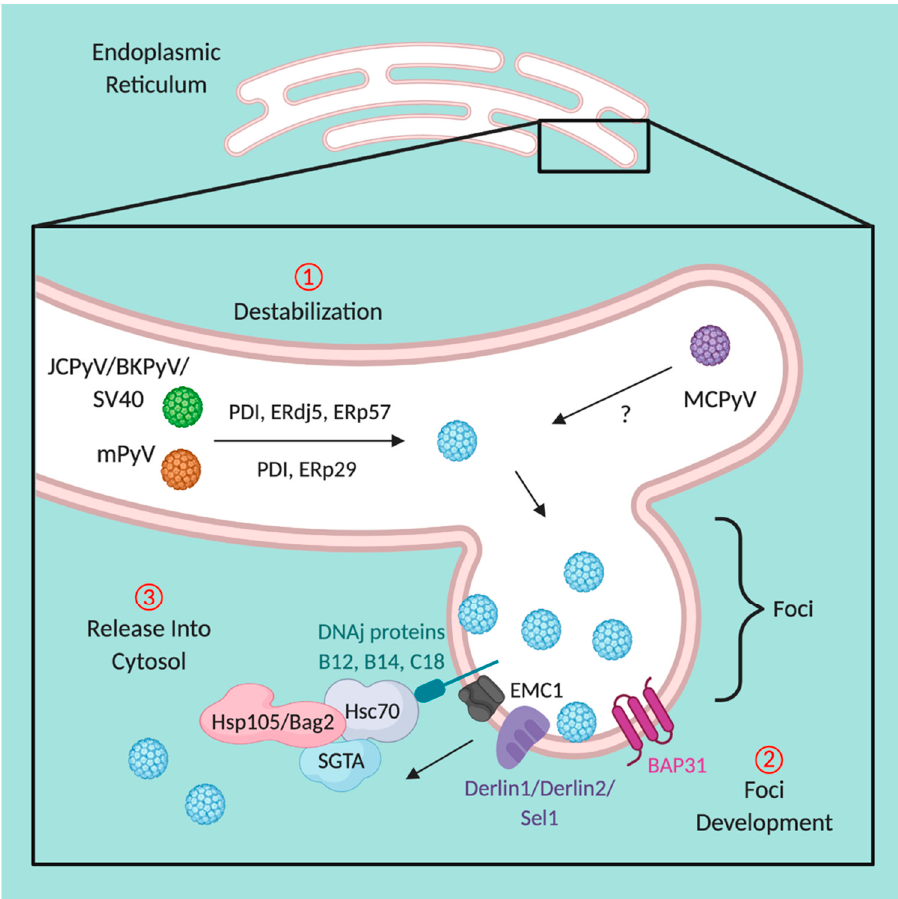
Figure 4. Release of polyomaviruses from the ER to the cytosol. (1) Upon arrival of polyomaviruses JCPyV, BKPyV, SV40 (green virion, collectively), mPyV (orange virion), and MCPyV (purple virion) in the ER, the viral capsids are destabilized due to reduction and isomerization of disulfide bonds by ER redox proteins, PDI, ERdj5, ERp57, or ERp29. Destabilization of MCPyV remains elusive (indicated by ‘?’). (2) The now-hydrophobic particle embeds itself in the ER membrane and is stabilized by EMC1, preventing further disassembly of the viral capsid. As demonstrated by SV40 (potential pathway of PyV convergence indicated by blue virion), localization of the virus in the membrane of the ER induces the relocation of DNA J proteins (B12, B14, C18) and BAP31 to the site, forming a foci. (3) Direct interactions between DNA J proteins and cytosolic extraction machinery (Hsc70, HSP105, Bag2, and SGTA) form a complex, and with the assistance of derlin1, derlin2, or sel1, facilitate the extraction of the virus across the ER membrane and into the cytosol, primed for arrival at the nucleus. Figure created with BioRender.com.